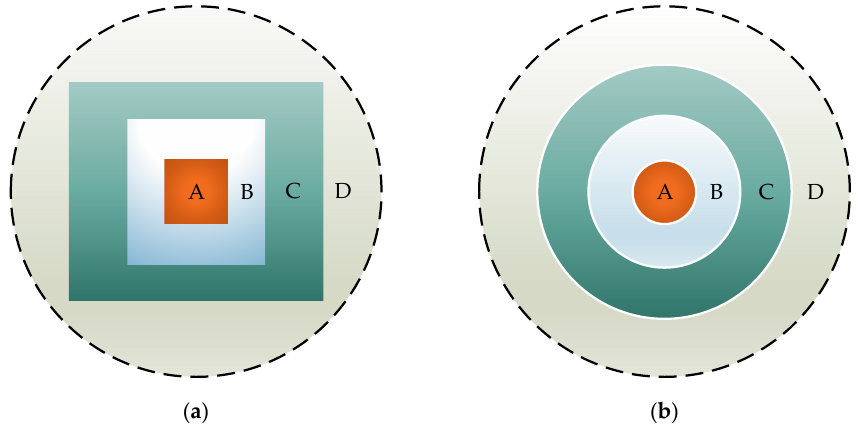
Figure 7. Geometry of source region of kfk_fe iron sphere benchmark. ( a ) Simplified geometry of experimental device. A, B, and C are the Cf-252 source, inner container, and outer container, respectively. D is the spherical iron shell. ( b ) Equivalent spherical source geometry based on volume ratio.